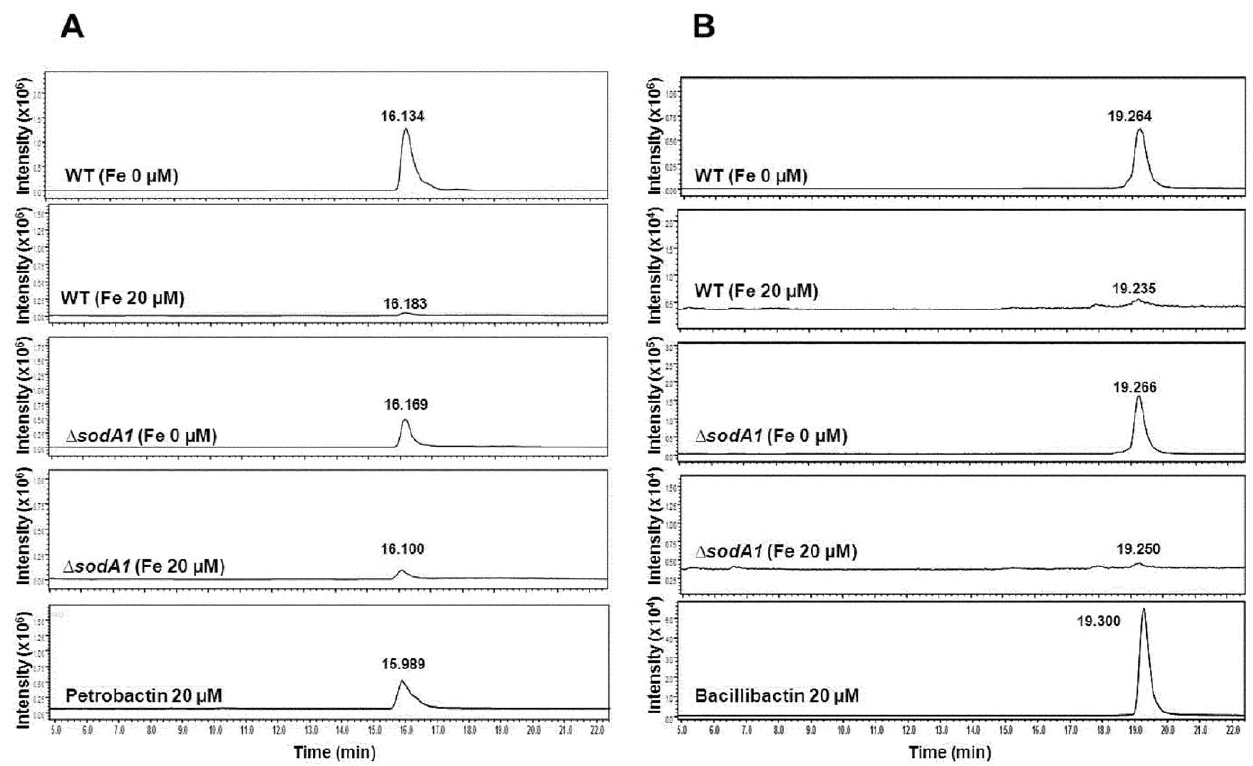
Figure 2. LCMS traces of extracts from the IDM cultures of B.anthracis showing the presence of petrobactin and bacillibactin with or without addition of iron. (A) Selected ion monitoring (SIM) chromatogram of petrobactin at the mass range of m/z 719.3 [M + H] + . The peaks at 15.989–16.183 min represent petrobactin. (B) SIM chromatogram of bacillibactin at the mass range of m/z 883.2 [M + H] + . The peaks at 19.235– 19.300 min represent bacillibactin.